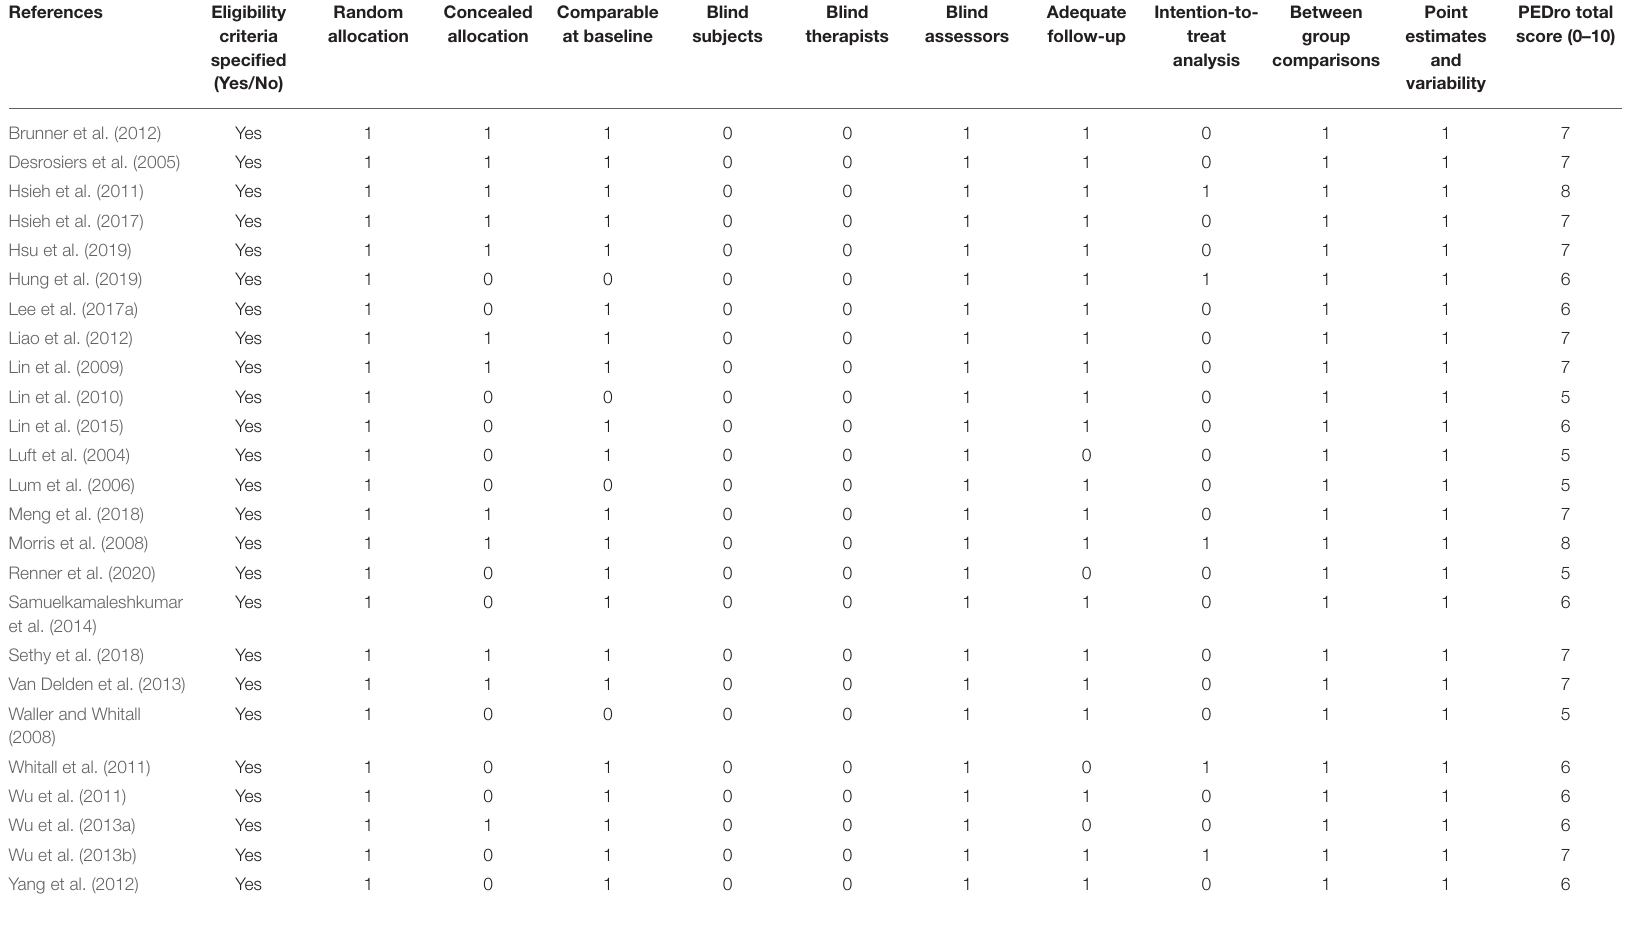
TABLE 3 | Methodological quality of included studies assessed by Physiotherapy Evidence Database (PEDro)